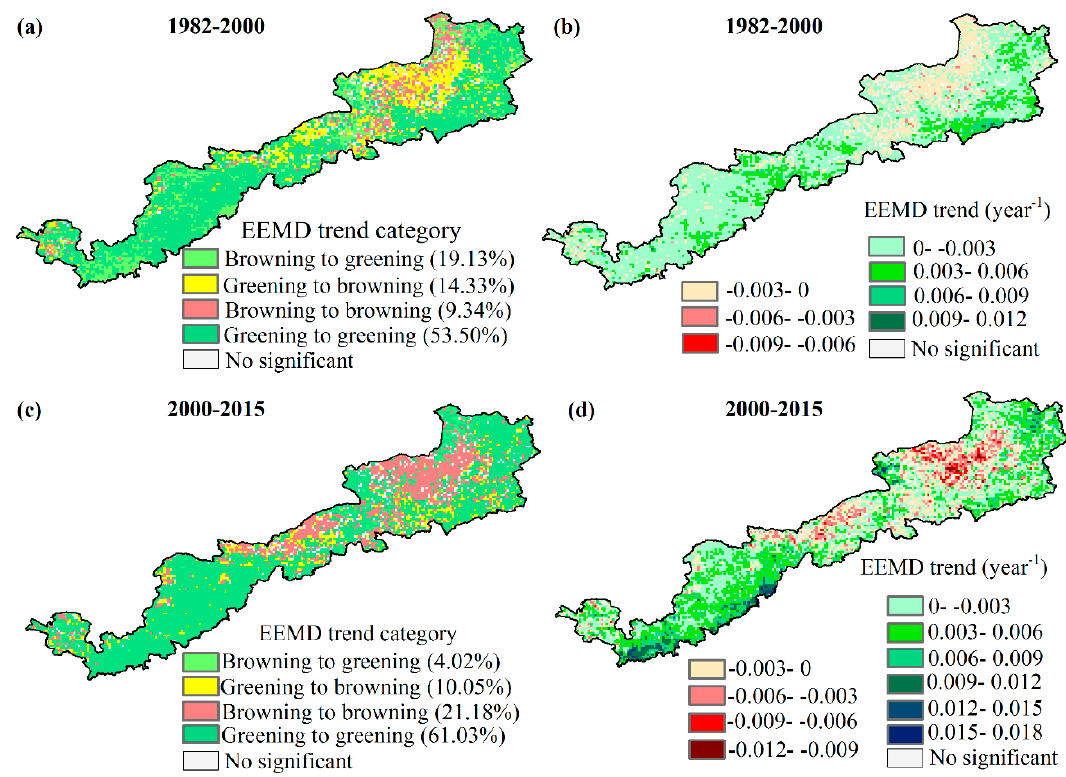
Figure 9. Spatial distribution of the EEMD trend classification ( a , c ) and variation rate ( b , d ) before and after 2000. Only pixels with P < 0.05 are presented.